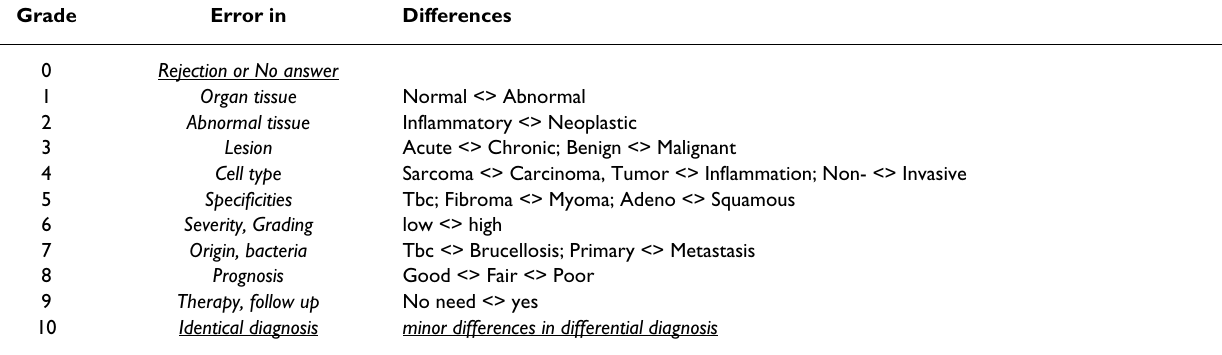
Table 3: Proposed error grading of potential medical differences between primary and expert diagnosis (according to [41].